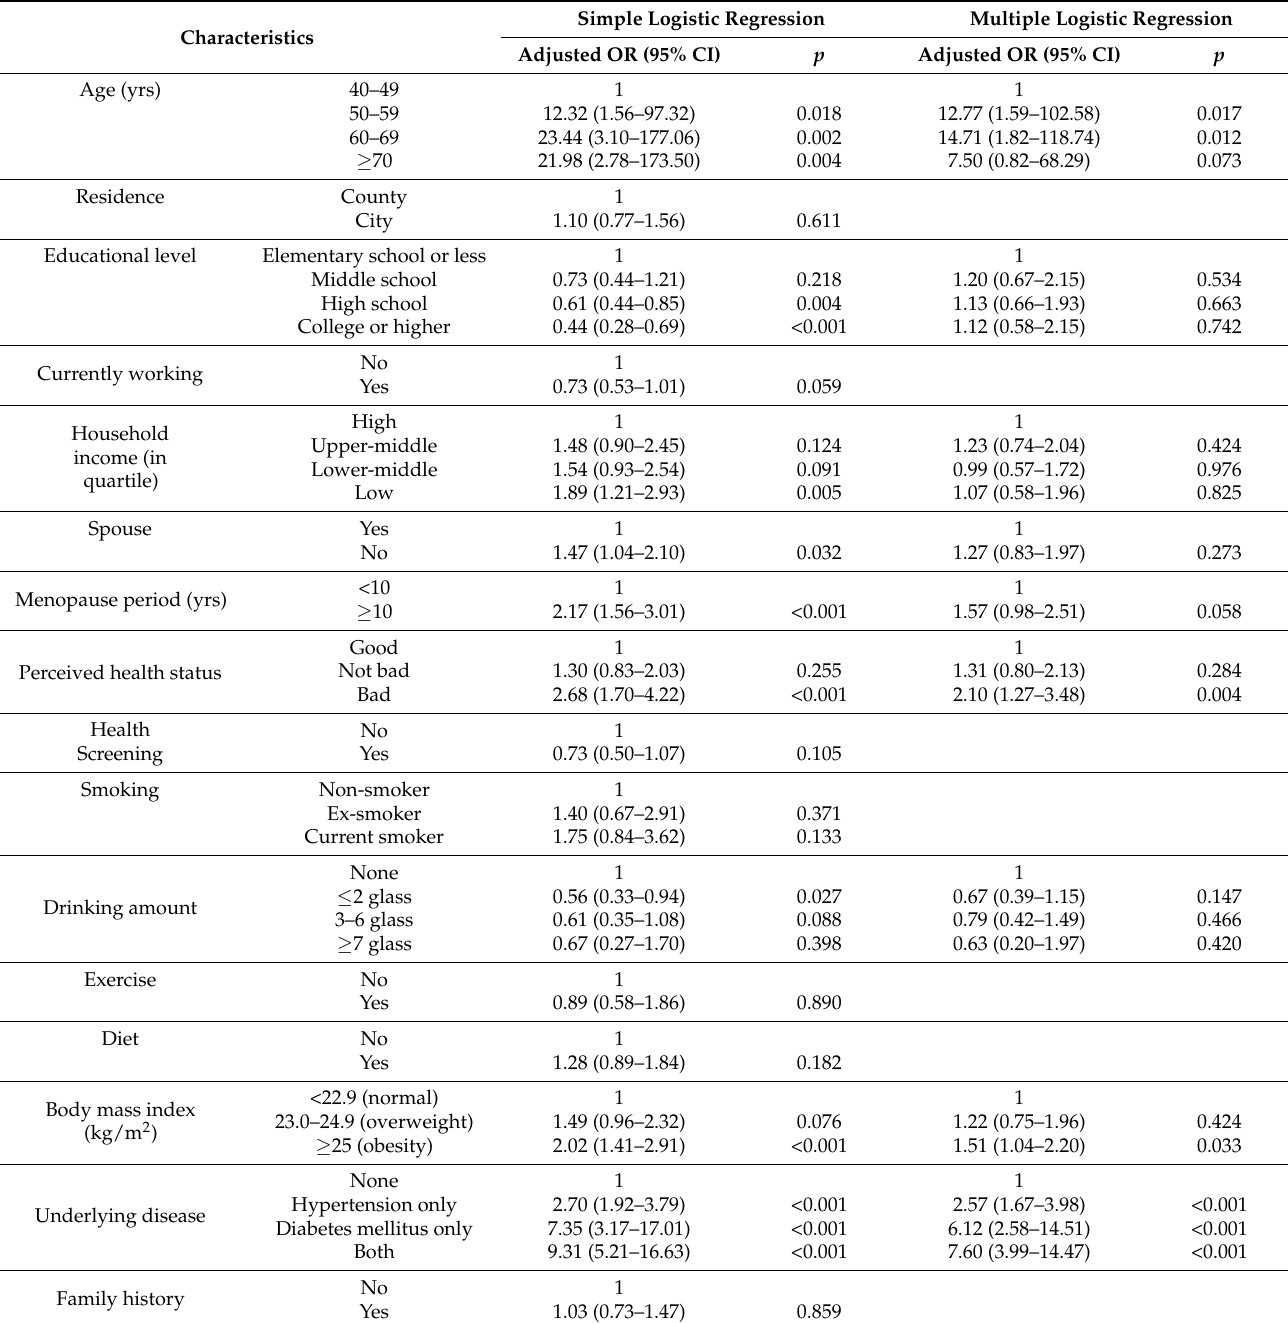
Table 3. Factors associated with dyslipidemia awareness in menopausal women ( n =